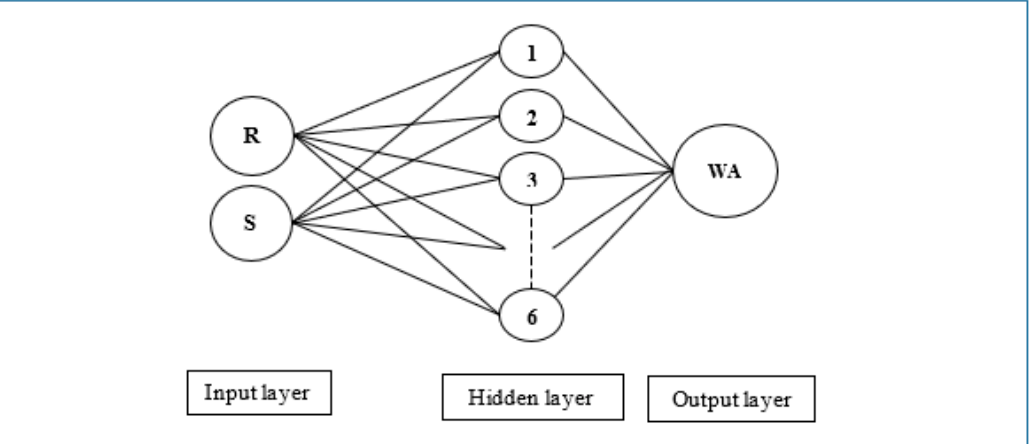
Figure 3. Artificial neuron network architecture for drum rotation-steel ball-water absorption.